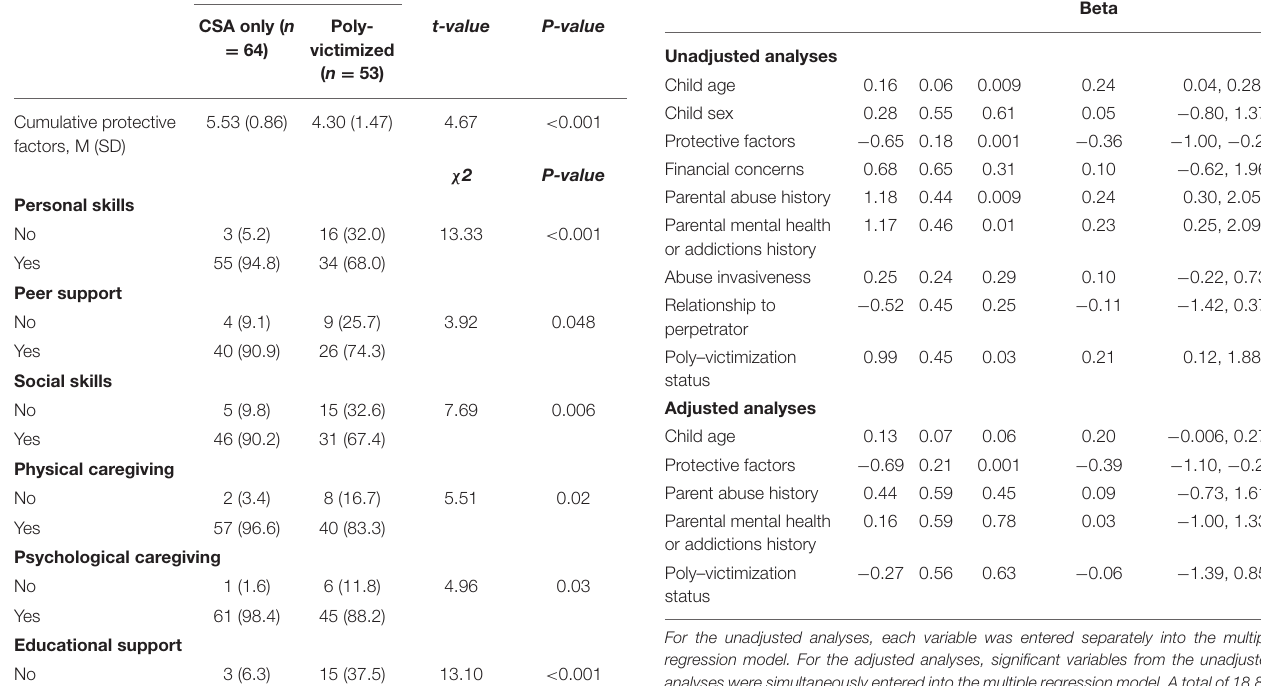
TABLE 6 | Differences in protective factors among children exposed to CSA only vs. those who were poly-victimized. Characteristic